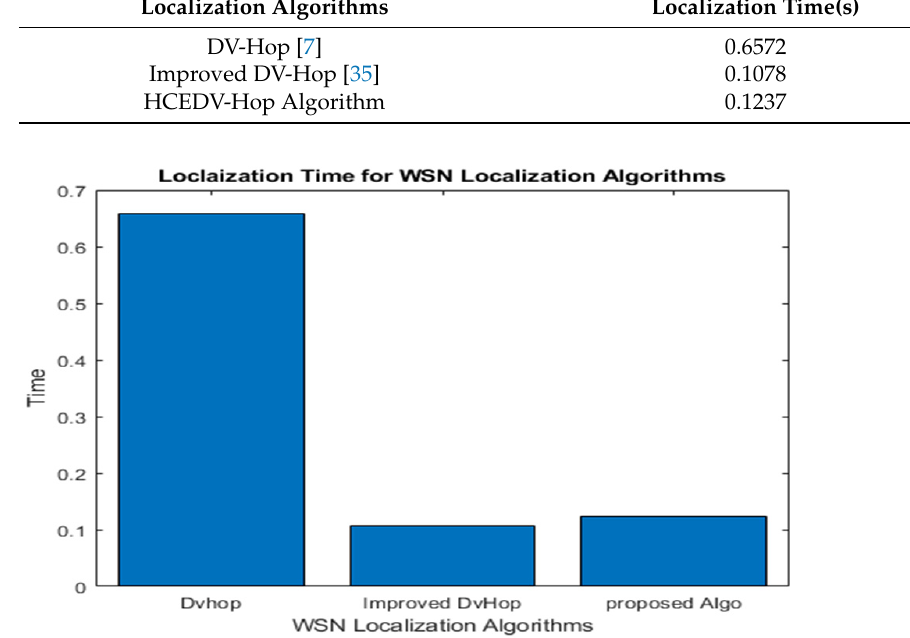
Table 14. Comparison of localization times for various localization algorithms. Localization Algorithms Localization Time(s)